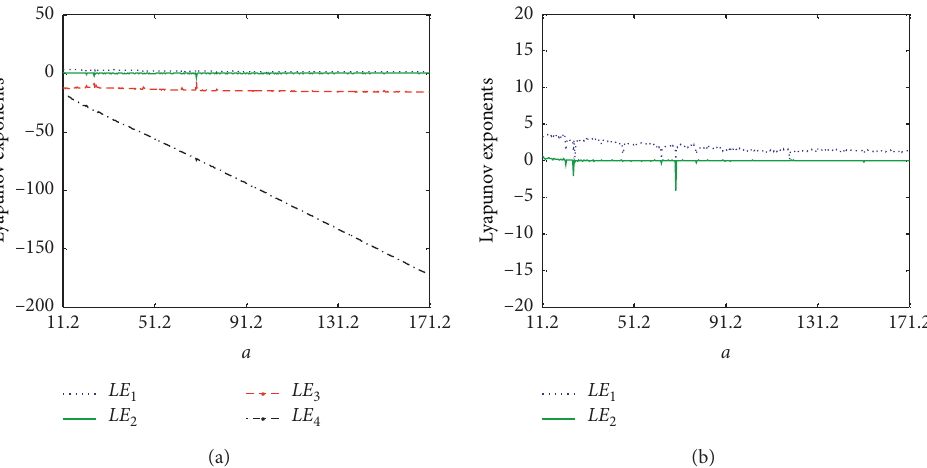
Figure 3: Lyapunov exponents for the proposed multiscroll chaotic system under M (-, +) with variation of α . (a) LE Closed-up view of LE 1 and LE 2